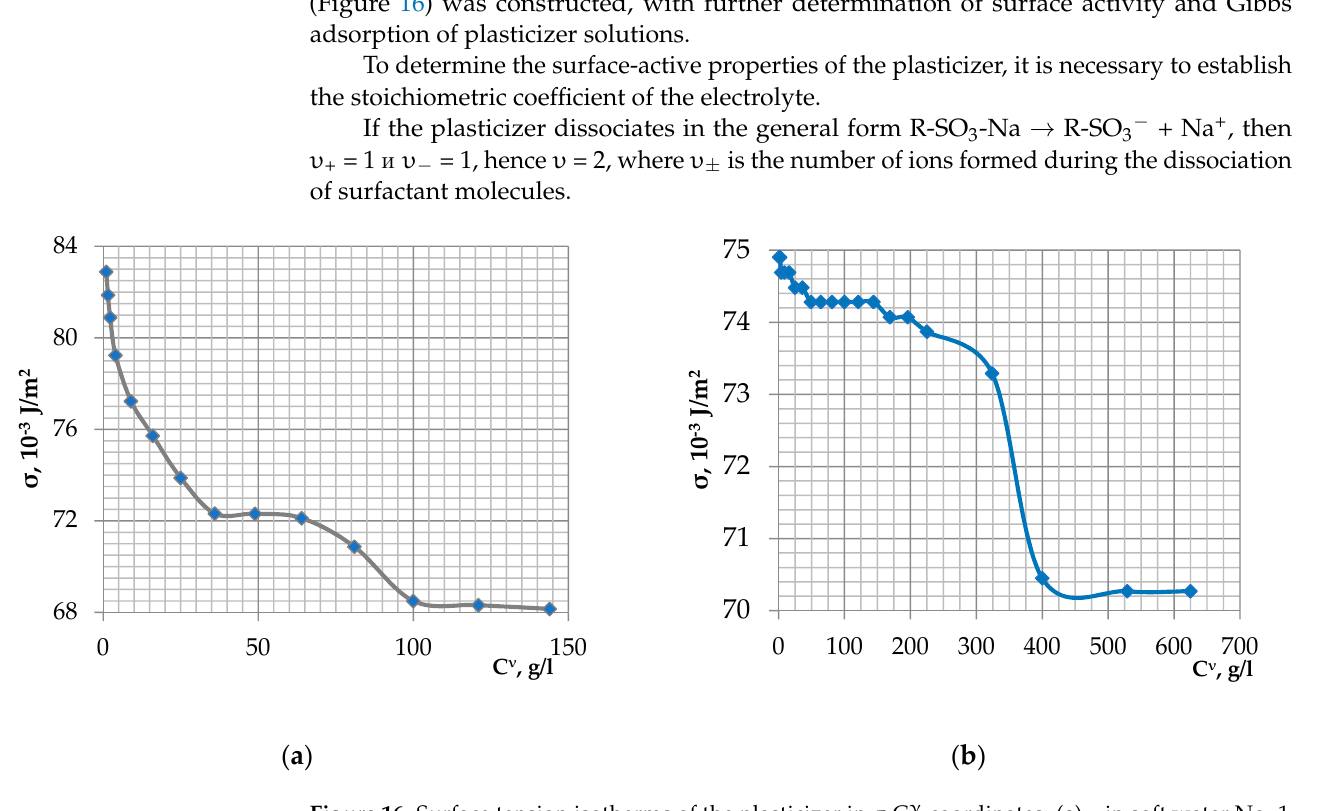
Figure 16. Surface tension isotherms of the plasticizer in σ -C ν coordinates: ( a )—in soft water No. 1, ( b )—in hard water No. 2.